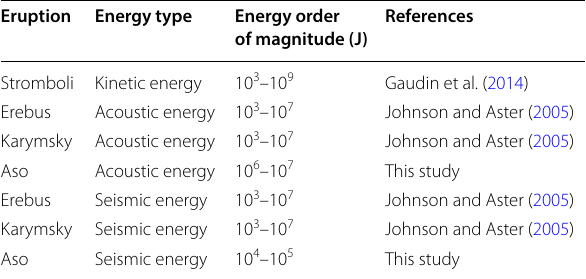
Table 5 Orders of kinetic, acoustic and seismic energies estimated for Strombolian